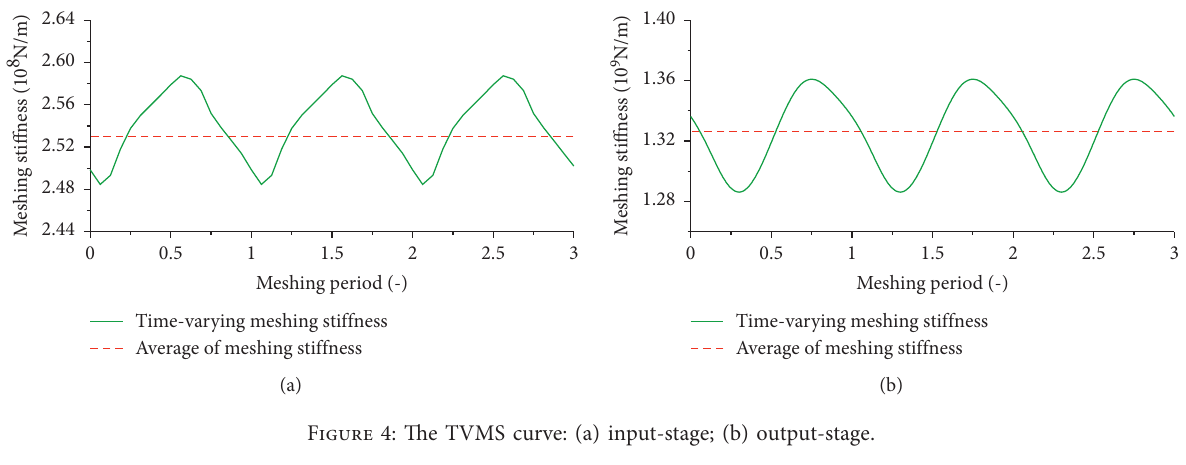
Figure 4: The TVMS curve: (a) input-stage; (b) output-stage.